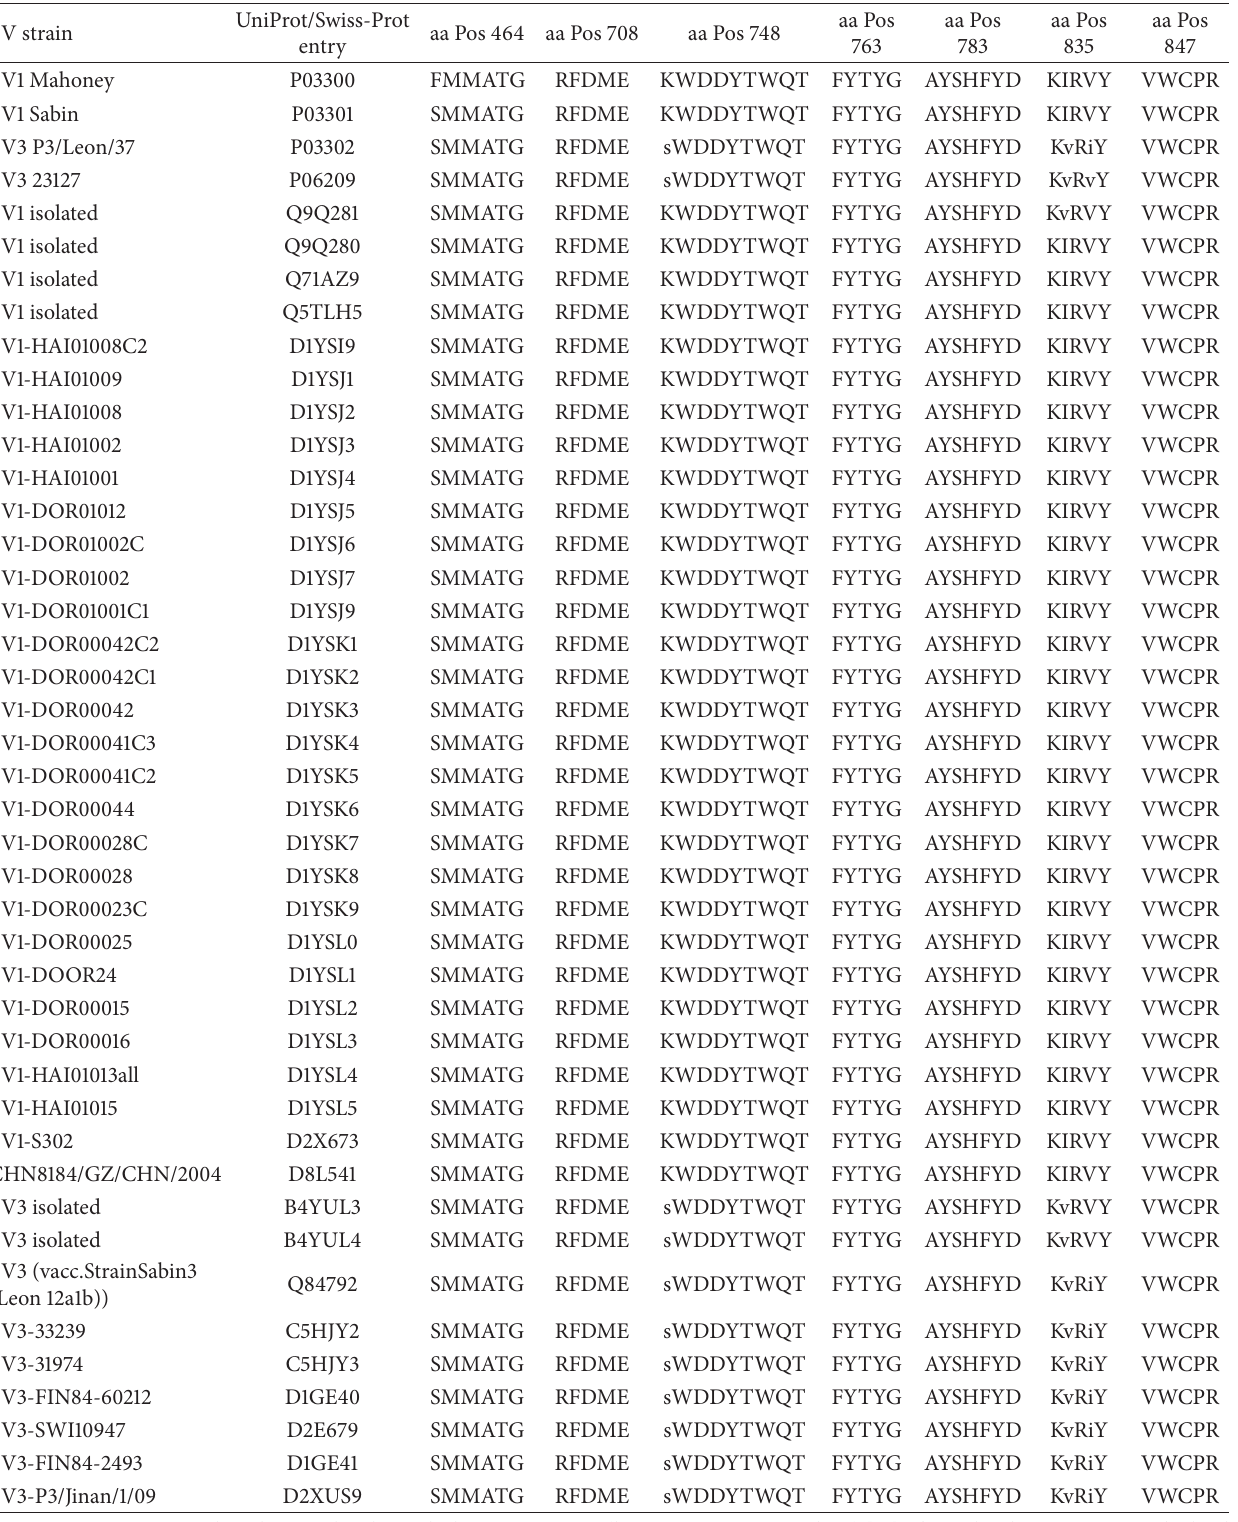
Table 3: Conservativeness of epitopic PV peptide regions among 43 PV strains and